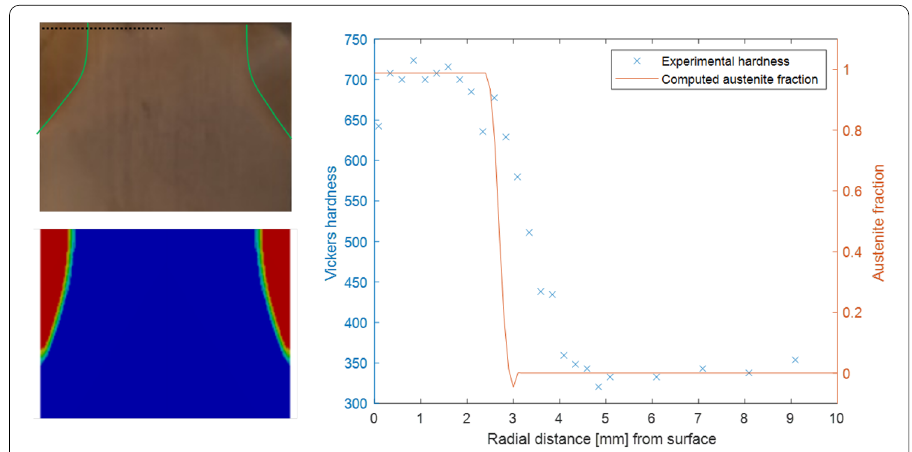
Fig. 10 Experimental and simulated hardened case for fully hardened region in red and end of transition zone in green (left) and Vickers Hardness measurement and simulated austenite fraction in the radial direction